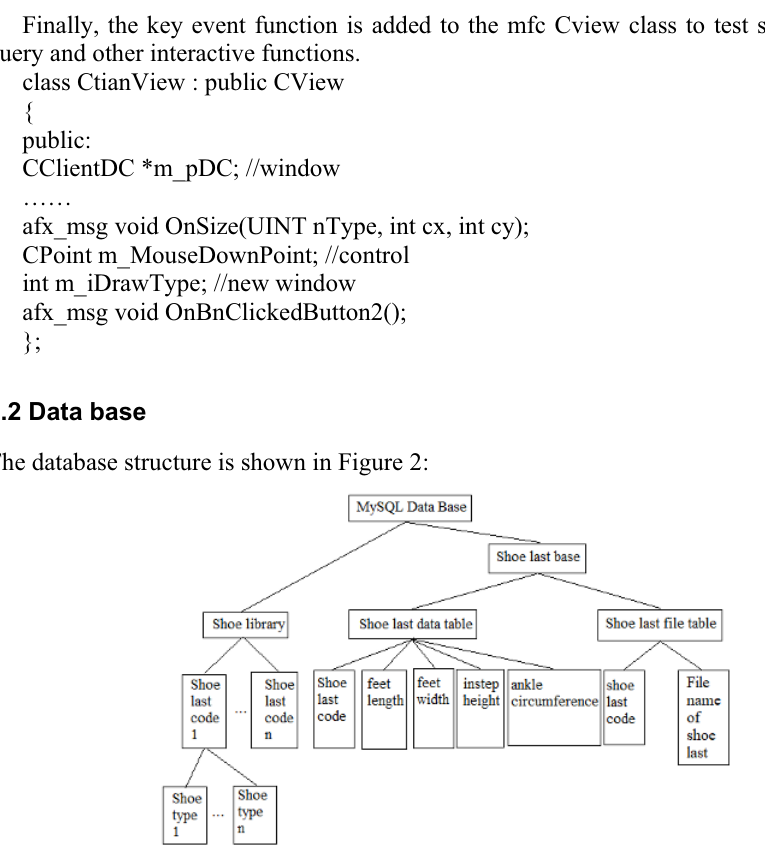
Fig. 2. Database structure chart.